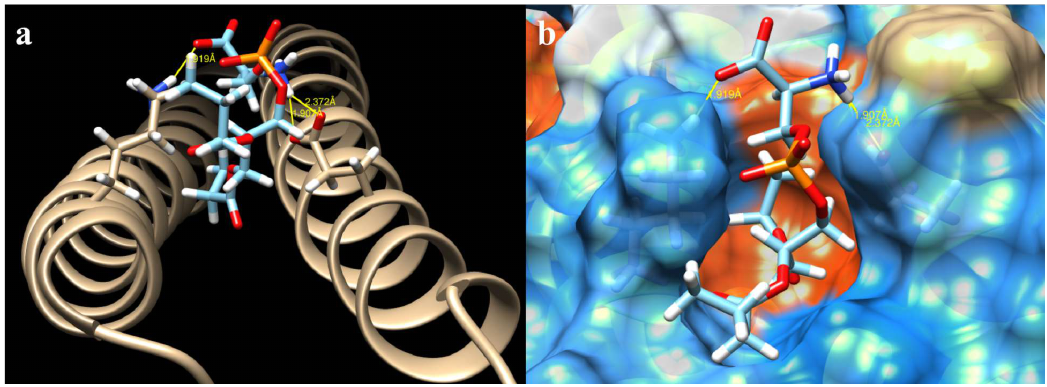
Figure 4. CagA–PS interaction of the mutation K636R obtained from Chimera: ( a ) hydrogen bonds and their distance (yellow lines) of interacting atoms are shown for both molecules; and ( b ) hydrophobic surface view of CagA, color-coded from dodger blue for the most hydrophilic, to white, to orange-red for the most